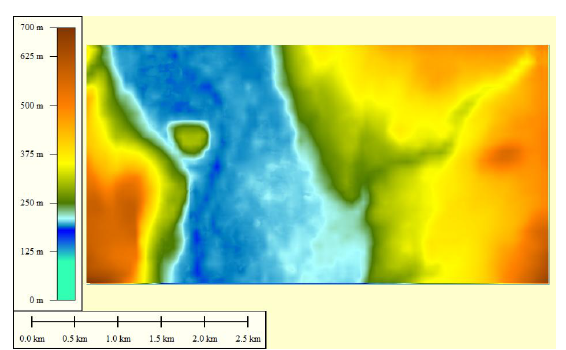
Figure 2: Merged DSM